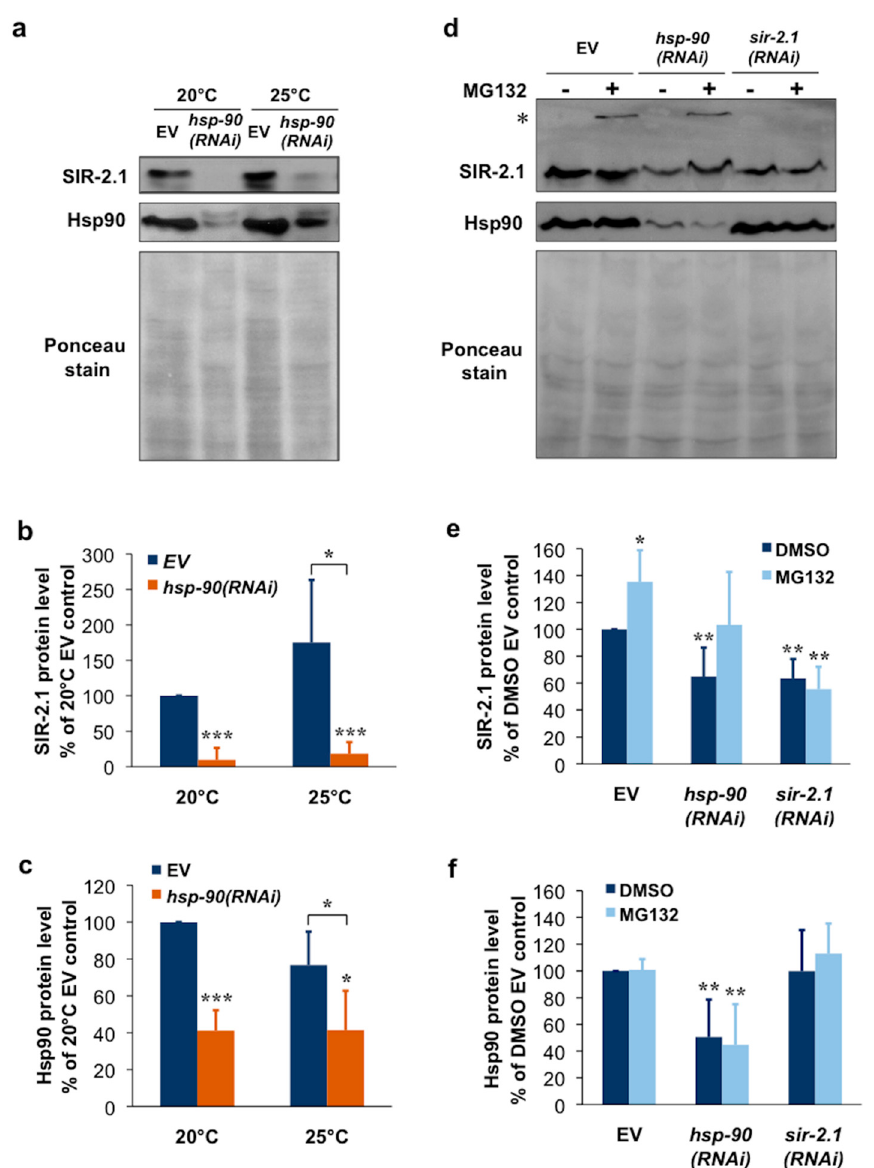
Figure 3. Hsp90 knockdown induces SIR-2.1 protein depletion and proteasomal degradation in C. elegans . ( a ) Effect of hsp-90(RNAi) on SIR-2.1 and Hsp90 protein levels. Western blots of lysates from young adult N2 wildtype nematodes treated with hsp-90(RNAi) or empty vector (EV) from hatching. Worms were kept at 20 or 25 °C. Images are representatives of three experiments. ( b , c ) Quantification of SIR-2.1 and Hsp90 protein levels from the experiment shown in panel ( a ). Values are means ± S.D. of three experiments and were statistically compared with the respective EV controls. * p < 0.05, *** p < 0.001 by two-tailed unpaired t -test. ( d ) hsp-90(RNAi) induces destabilization and proteasomal degradation of the SIR-2.1 protein. Western blots of total lysates from young adult N2 wildtype nematodes treated with hsp-90(RNAi) , sir-2.1(RNAi) or empty vector (EV) from hatching and transferred to plates at the L2 stage containing 10 μ M MG132 or DMSO vehicle. Images are representatives of four experiments. Asterisk (*) indicate anti-SIR-2.1 reactive protein aggregates accumulated on the top of the gel in the MG132-treated EV and hsp-90(RNAi) , but not the sir-2.1(RNAi) lanes. ( e , f ) Quantification of SIR.2.1 and Hsp90 protein levels from the experiment shown in panel ( d ). Values are means ± S.D. of four experiments and were statistically compared with the respective controls. * p < 0.05, ** p < 0.01 by two-tailed unpaired t -test.